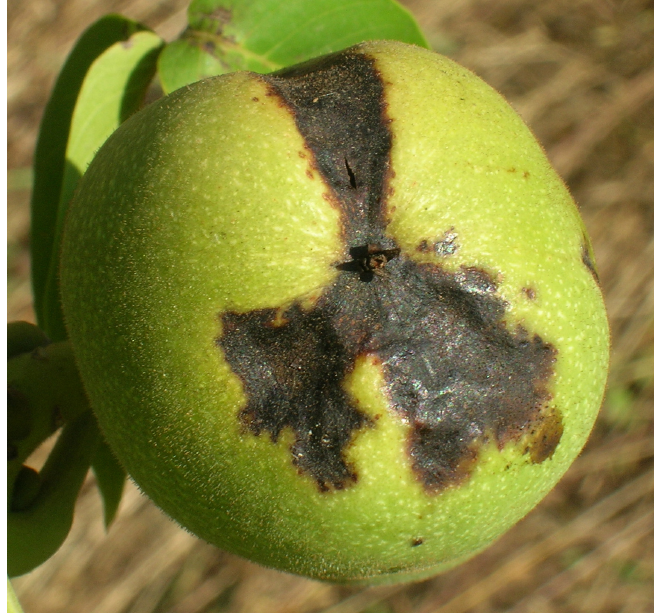
Figure 2. Apical necrosis incited by Xanthomonas arboricola pv. juglandis to Juglams regia